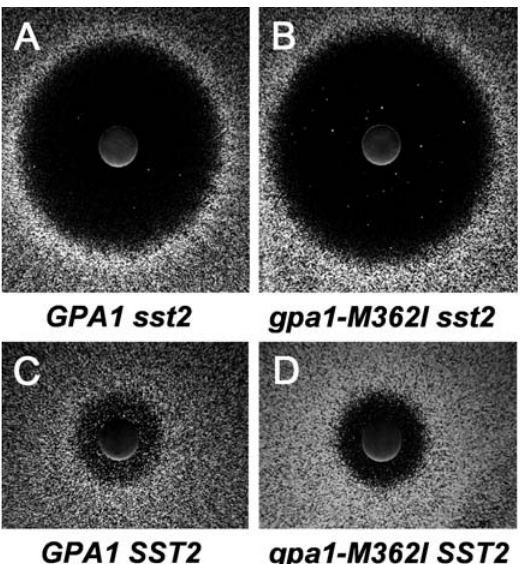
Figure 9. The Yeast gpa1-M362I Mutant Allele Causes a Hypo-Adaptation Phenotype Images show the growth of a monolayer of yeast cells around a paper disc containing alpha factor, the peptide ligand for the Ste3 GPCR. A zone of growth inhibition is visible as a ‘‘ halo ’’ around each disc. (A) Yeast strain contains a wild-type G- a q gene (GPA1) and has a chromosomal deletion of the SST2 gene, encoding an RGS protein. (B) Yeast strain contains a wild-type G- a q gene (GPA1) and a chromosomal deletion of the SST2 gene, but carries wild-type SST2 on a plasmid. (C) Yeast strain contains a mutant G- a q gene (gpa1-M362I) and has a chromosomal deletion of the SST2 gene, encoding an RGS protein. (D) Yeast strain contains a mutant G- a q gene (gpa1-M362I) and a chromosomal deletion of the SST2 gene, but carries wild-type SST2 on